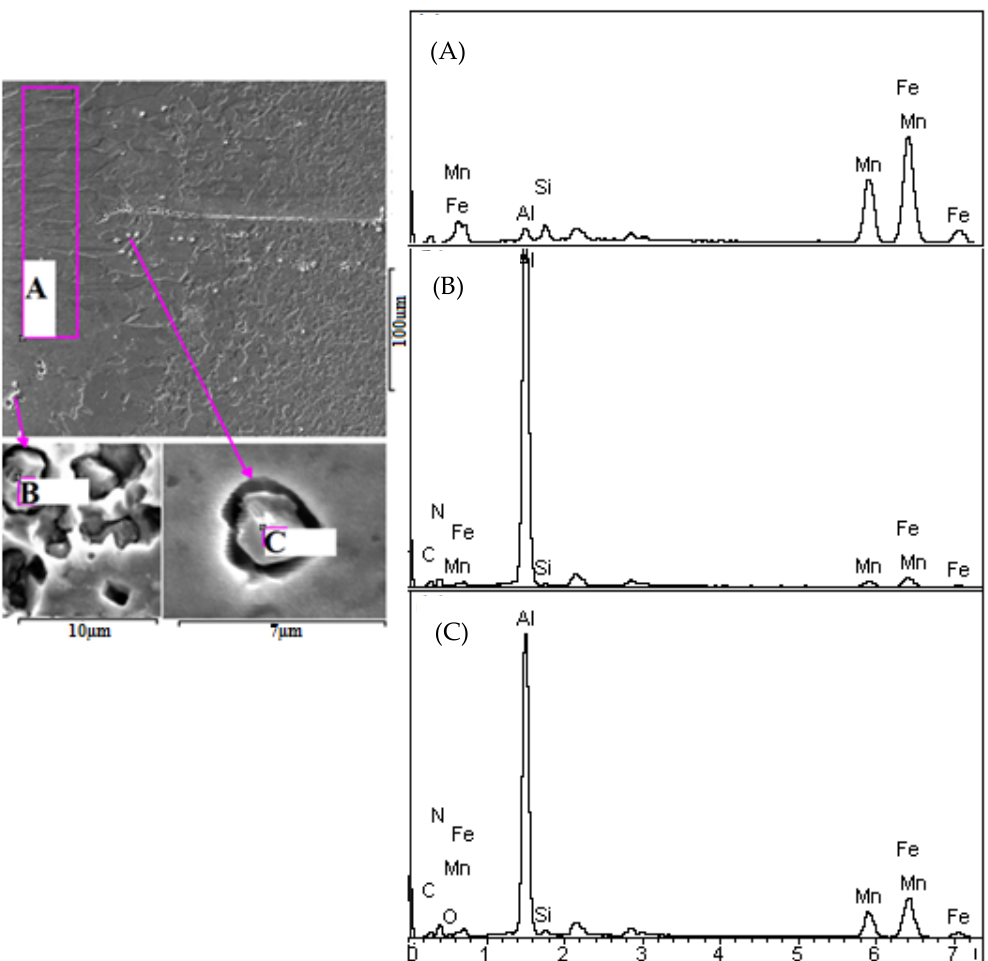
Figure 8. EDS analysis results of welded samples ( A ) EDS analysis of weld nugget ( B ) EDS analysis of particles in weld nugget, ( C ) EDS analysis of particles in HAZ